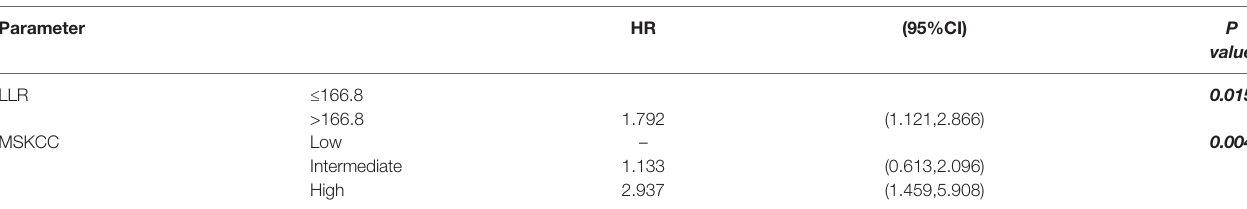
TABLE 4 | Multivariate analysis of variables associated with overall survival.